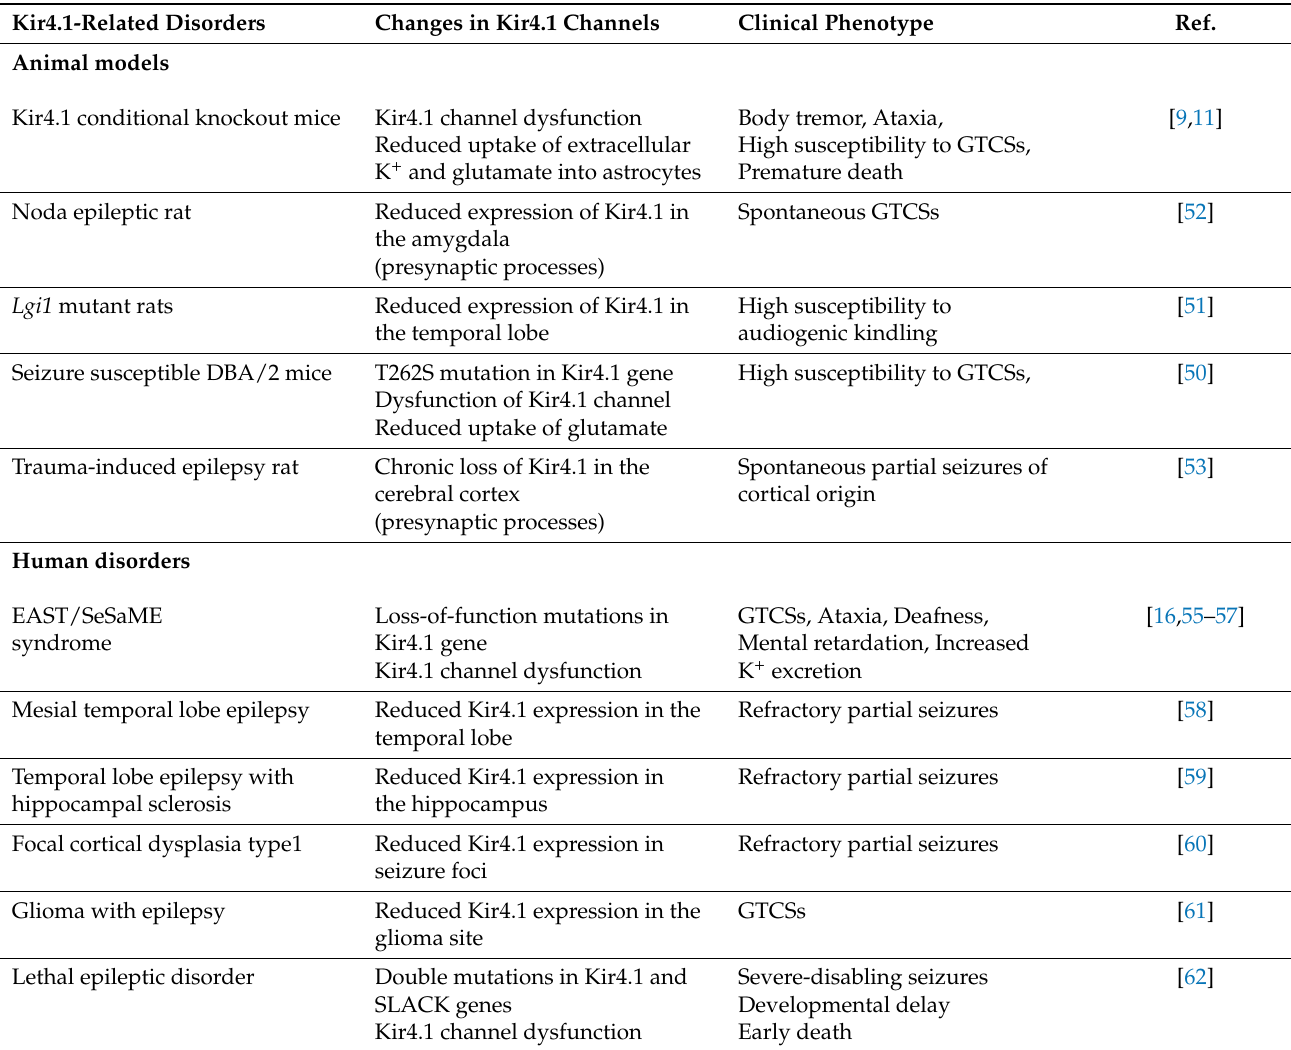
Table 2. Pathophysiological changes in Kir4.1 channels in animal models and human disorders. Kir4.1-Related Disorders